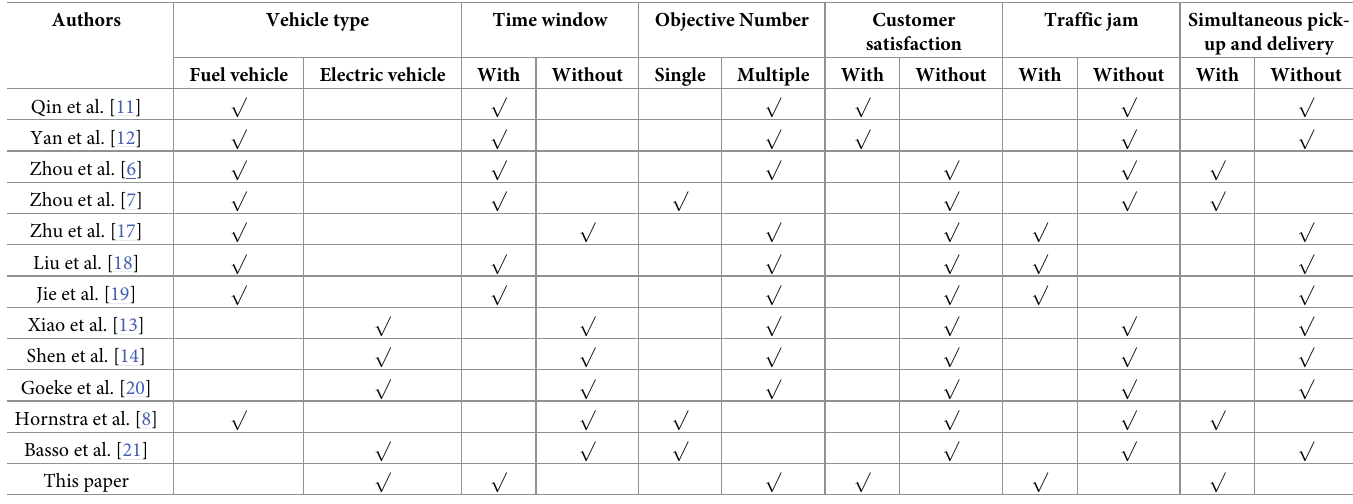
Table 1. Summary of relevant